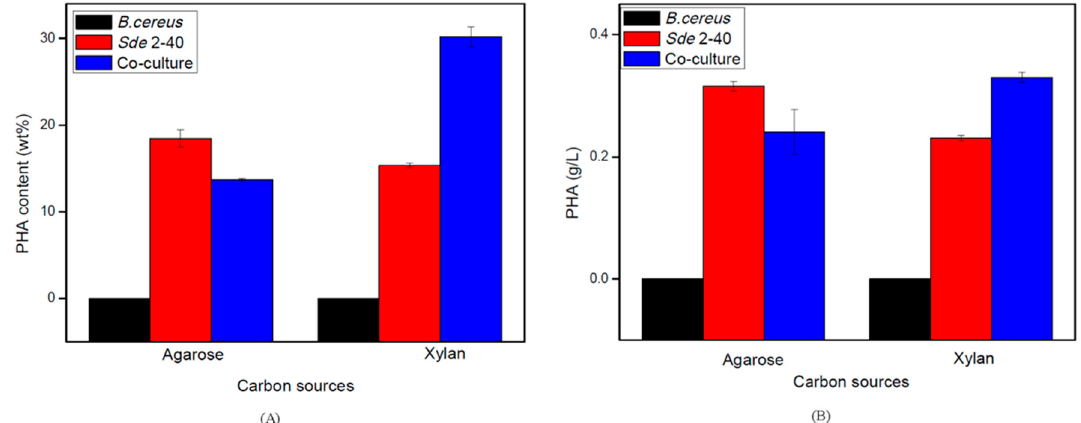
Figure 10. Production of PHA in two step culture. Cells grown on nutrient balanced medium were transferred to nitrogen free medium. ( A ) PHA contents of Sde 2-40, B. cereus , and co-culture on agarose and xylan; ( B ) PHA concentrations of Sde 2-40, B. cereus , and co-culture on agarose and